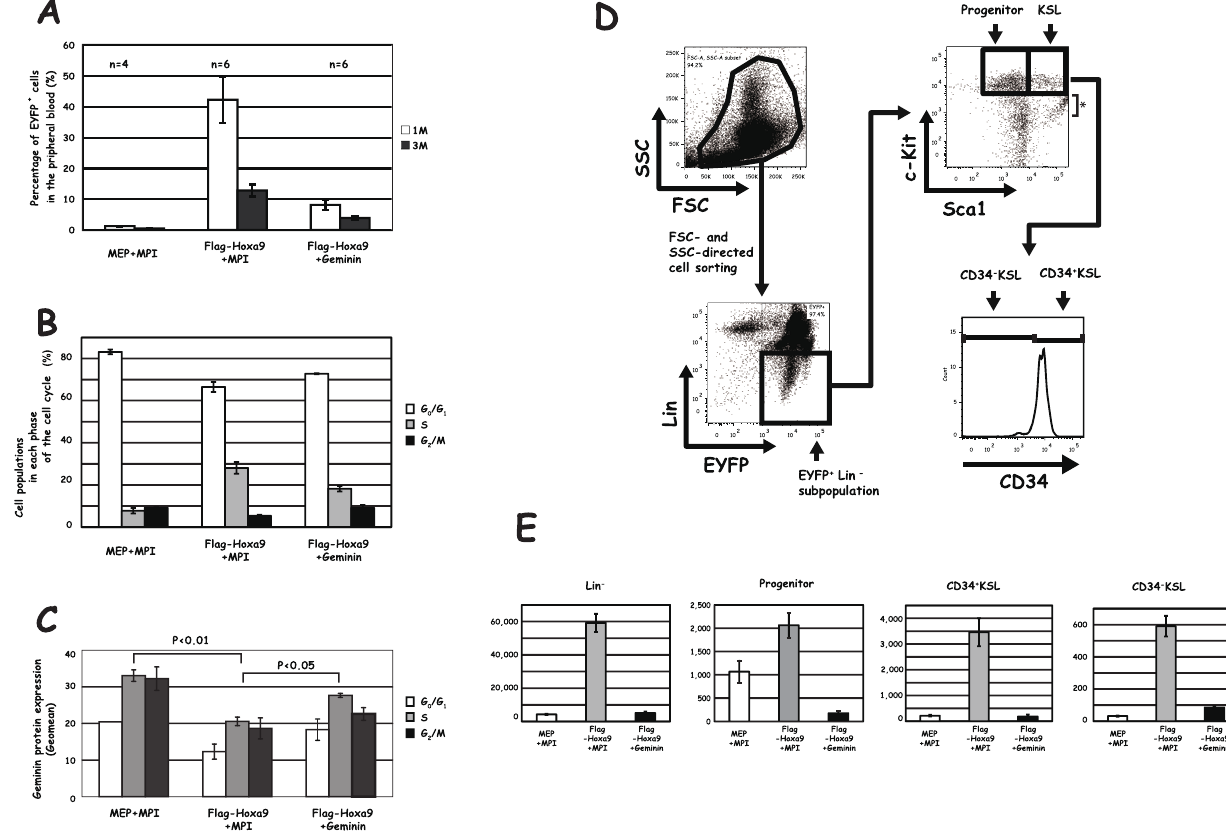
Figure 7. Effect of Geminin supertransduction on Hoxa9 transduction-mediated hematopoietic induction in reconstituted BM. ( A ) Repopulating activities of retrovirally transduced BM. Repopulating activities in the reconstituted mice were examined 1 month (1M) and 3 months (3M) after the injection. Since the repopulating activity was low in MEP + MPI-transduced BM, mice injected with 5-fold higher numbers of retrovirally transduced cells were used in subsequent analyses as controls. The number of recipient mice is indicated above each bar. ( B ) Cell populations in each phase of the cell cycle were analyzed by cell sorting analysis. ( C ) Geminin protein expression in each phase of the cell cycle. ( D ) Cell sorting procedure for analyzing the primitive hematopoietic cells. BM were subjected to cell sorting analysis. Primitive hematopoietic cells in EYFP + cells were examined by the immunophenotype analysis. *, cells with a non-specific Sca1 signal due to the spectrum overlap ( E ) Cell numbers of Lin 2 , progenitor, CD34 + KSL and CD34 2 KSL subpopulations in BM from the reconstituted mice. The data from three independent mice were subjected to the statistical analysis. MEP and MPI, empty control vectors.